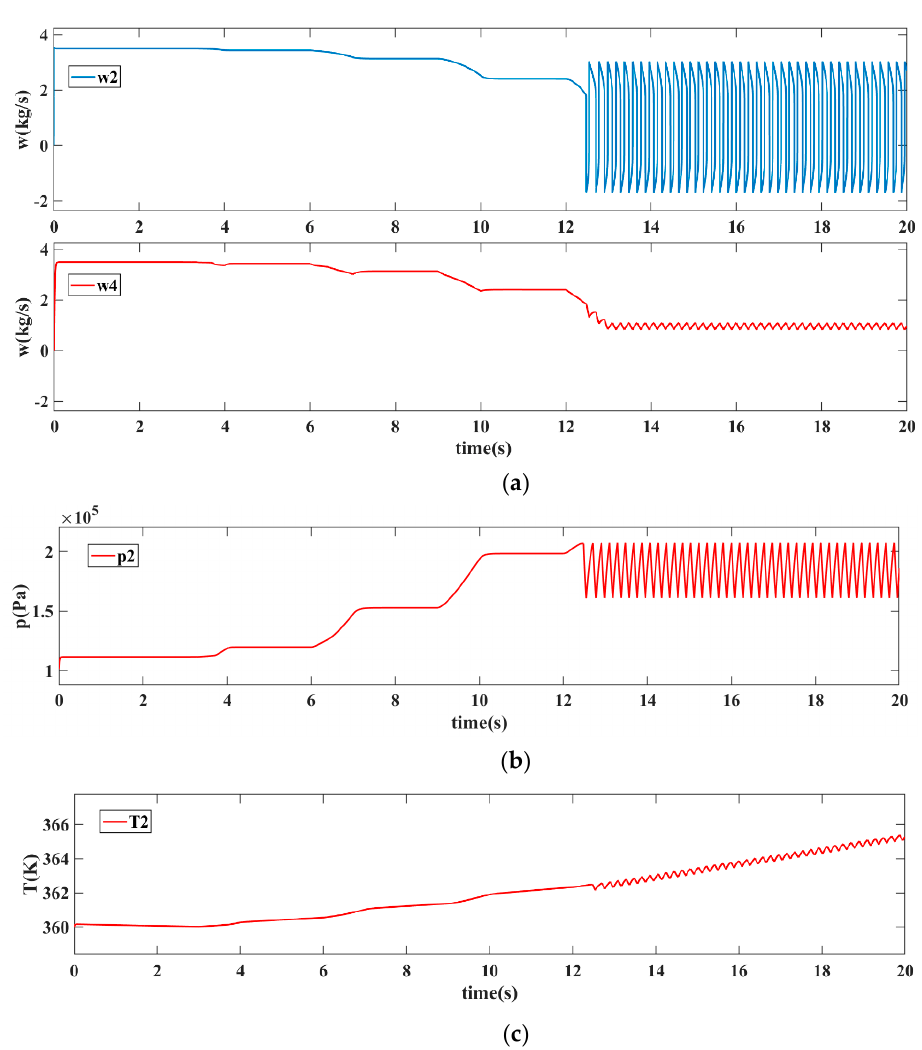
Figure 11. Compressor operating trajectory of the compression system with one throttle valve. Where the red solid line is the track of the migration of operating points, and the black dotted line is the compressor performance curve. The points “ABCDEF” are the key node for the change of compressor working condition. The blue shear head represents the direction of migration of work- ing condition point during surge.